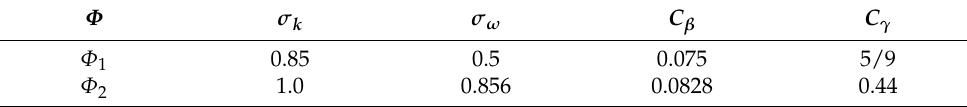
Table 1. Default values for Φ 1 and Φ 2